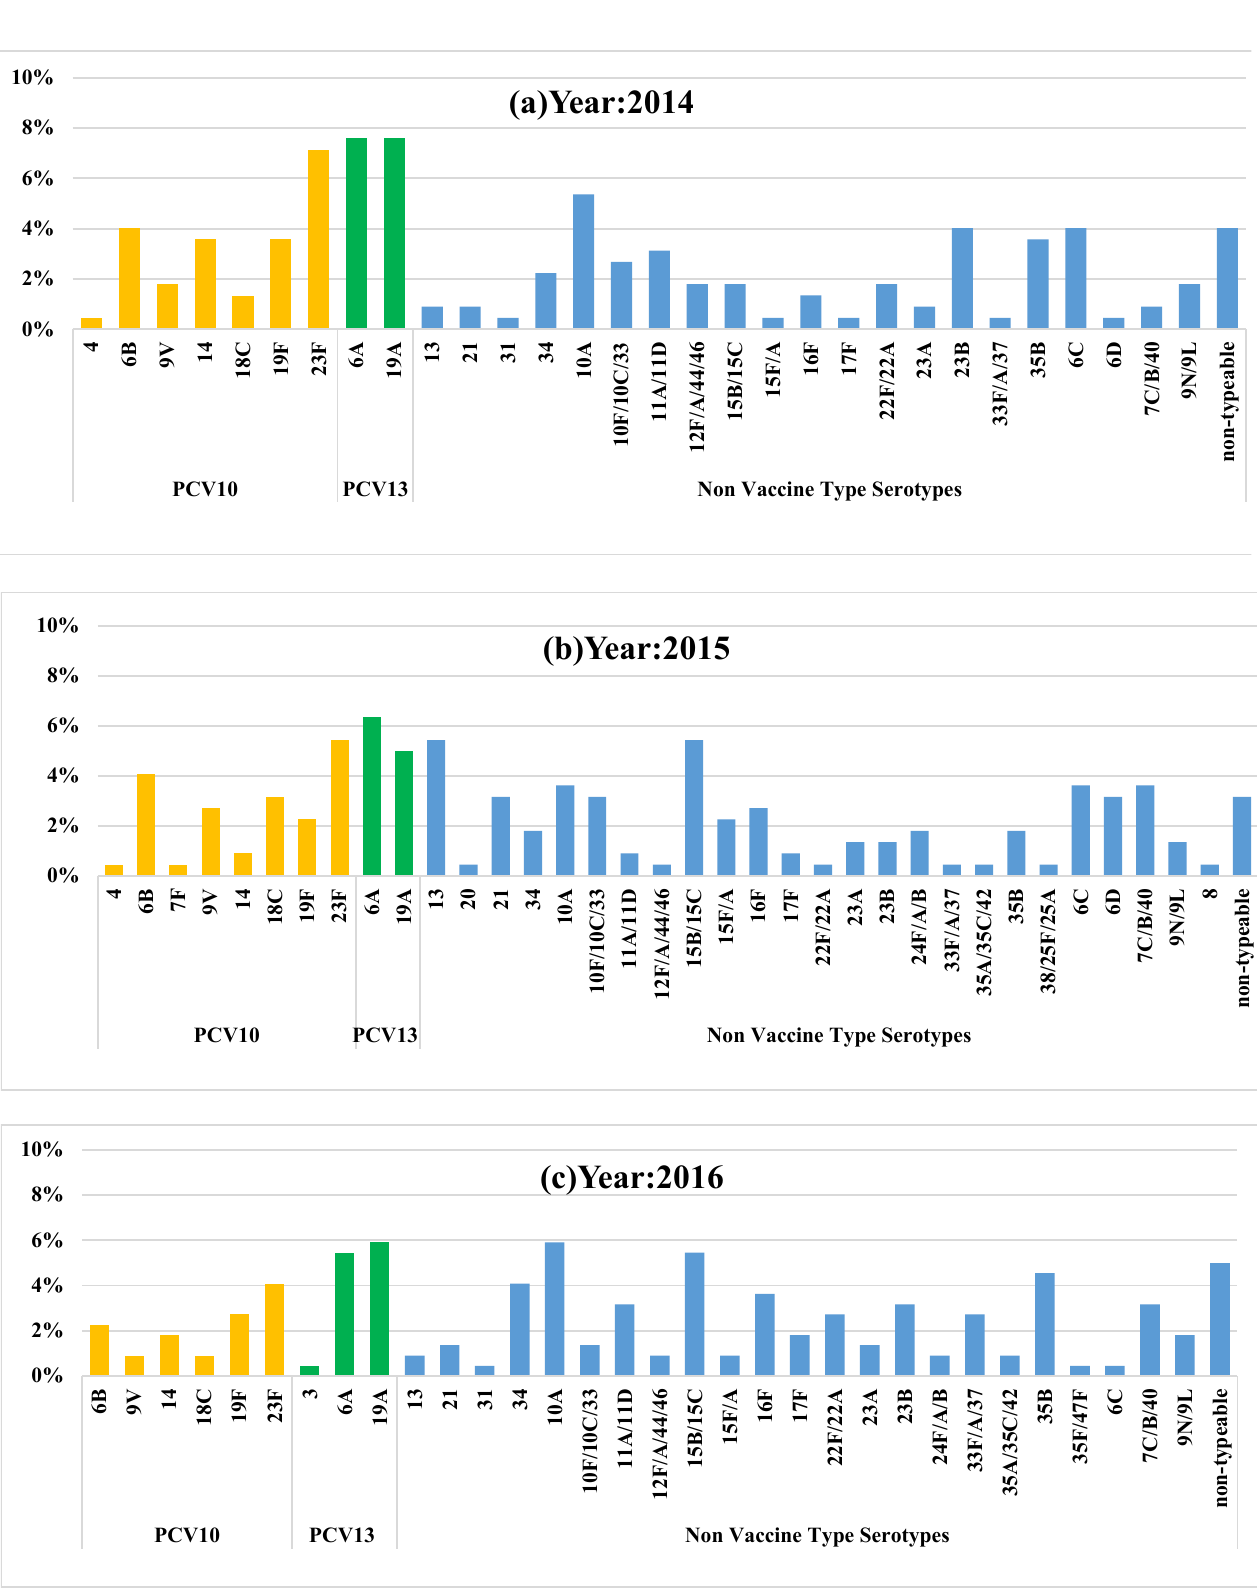
Figure 1. Proportion of children carrying PCV10, PCV13, and NVT serotypes over time. Rates for 2013 are from a previously published survey in the same community by the same group of authors.